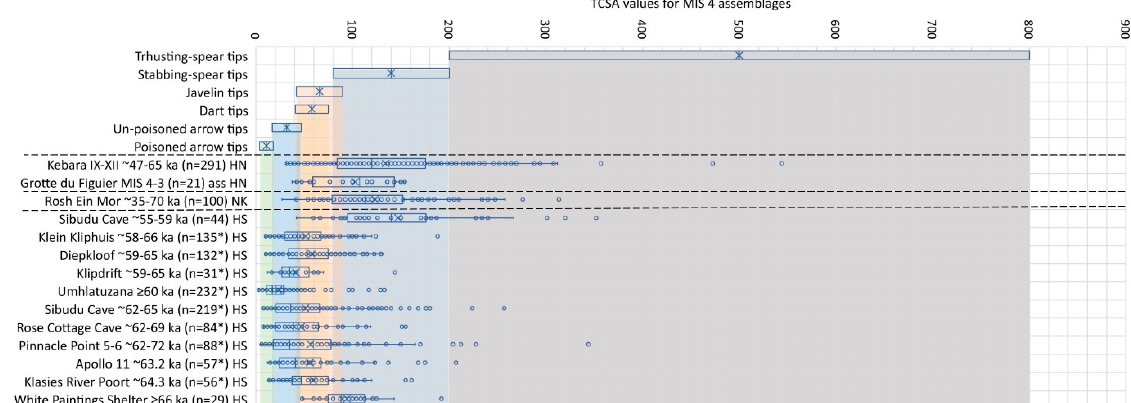
Figure 5. Comparative analysis of TCSA values for assemblages dating to MIS 4. Hominin abbreviation key: Same as for Figure 3, but ass HN = assemblages with no human fossil material but assumed to be associated with H. neanderthalensis based on technology or dating only, even though H. sapiens may have been on the landscape. The key to boxplot information is the same as for Figure 2. Data sources: Kebara [40,41]; Rosh Ein Mor [40]; Southern African assemblages [36].